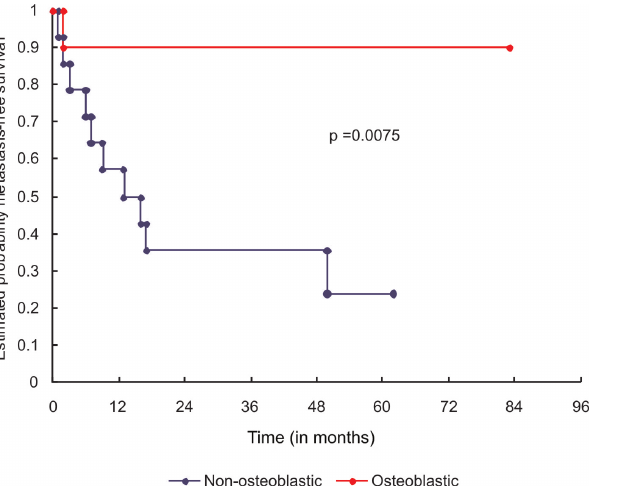
Figure 9 - Curve of metastasis-free survival in months for the 24 patients with primary osteosarcoma that was non-metastatic at diagnosis, according to histological type